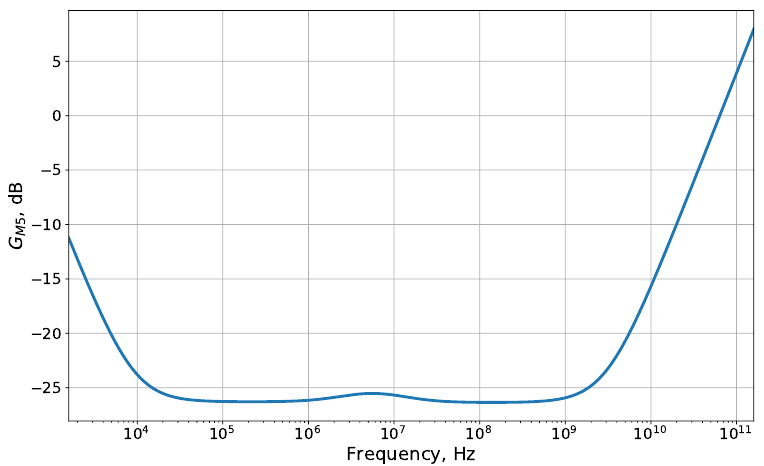
Figure 7. Shaping filter due to G M5 (example case for TSMC 0.18 µ m